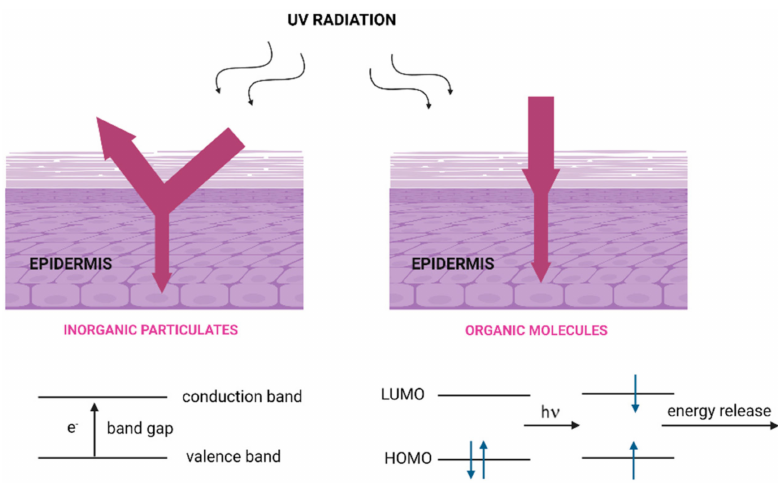
Figure 1. Method of action of inorganic ( left ) and organic ( right ) UV